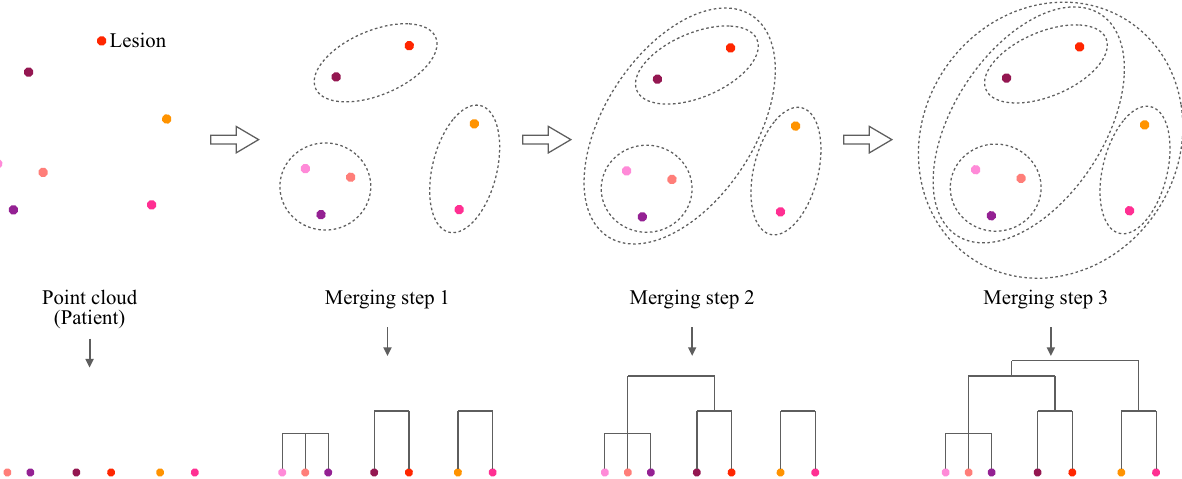
Figure 5. Tree-based patient representation via agglomerative hierarchical clustering: from the bottom up to the root, leaves get agglomerated and merged into bigger and bigger clusters, to finally converge in a single set. As a consequence, tree branches reflect pairwise similarity between lesions and the tree structure surrogates the overall dispersion among peer lesions. In the final dendrogram representation, leaves are the lesions of the patient and edges illustrate the similarity-connection between them. Leaves that are close to each other are intended by construction to be similar and exhibit a comparable radiomic profile (homogeneous) while distant leaves can be thought as lesions expressing different imaging phenotypes (heterogeneous). In this sense, dendrogram structure entails the heterogeneity quantification within the tumor, which needs to be